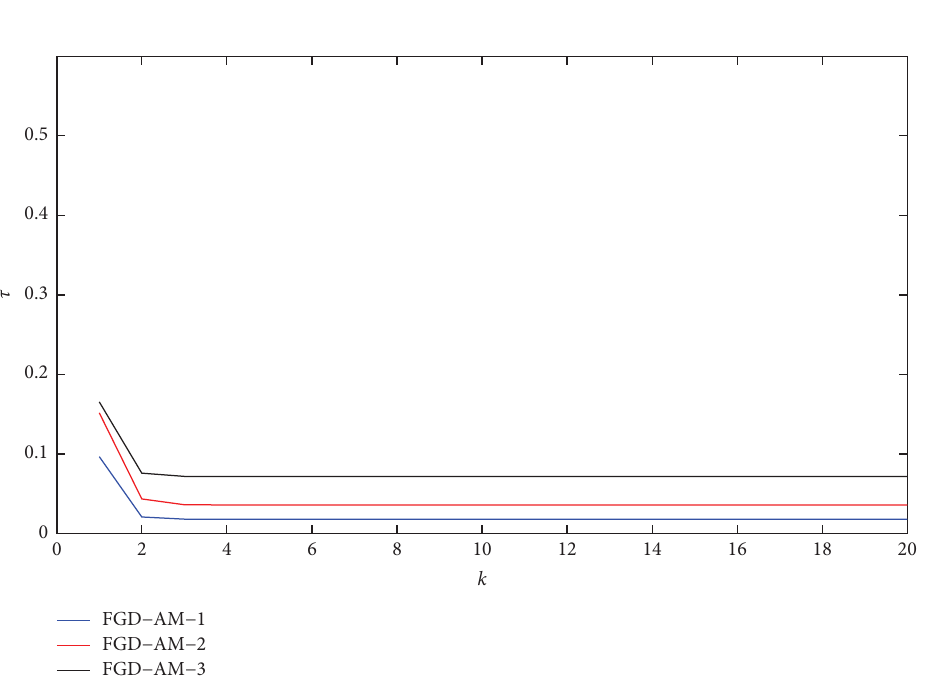
Figure 3: Te true outputs and estimated outputs.